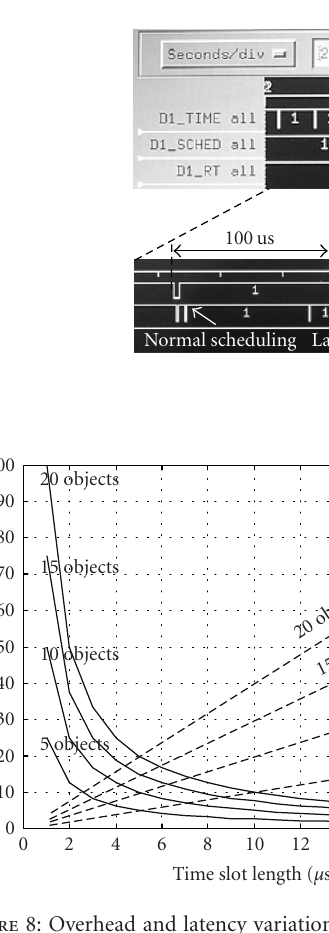
Figure 8: Overhead and latency variation as a function of objects and time